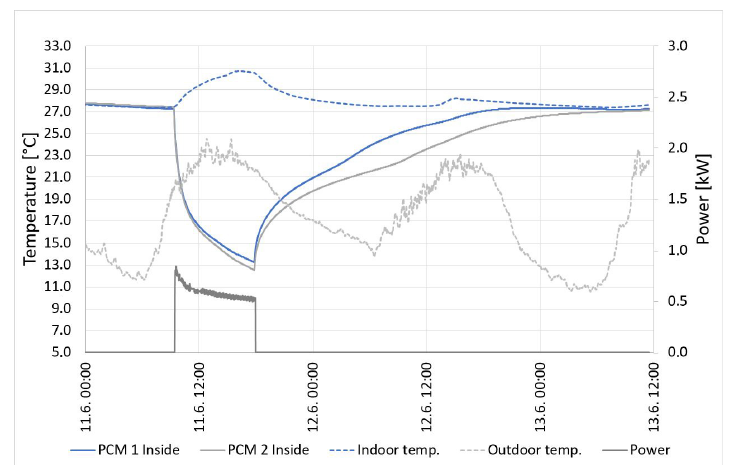
Figure 5. Technical issue with overheating.